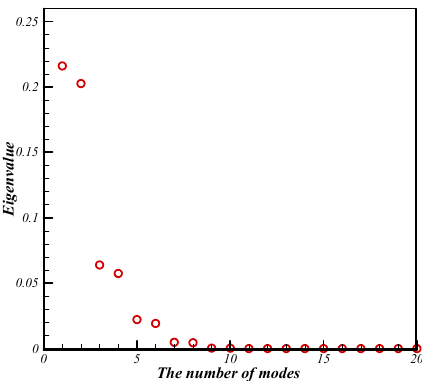
Figure A2. The eigenvalues with the number of modes (NACA0012, 12 CST). Aerospace 2022 , 9 , x FOR PEER REVIEW